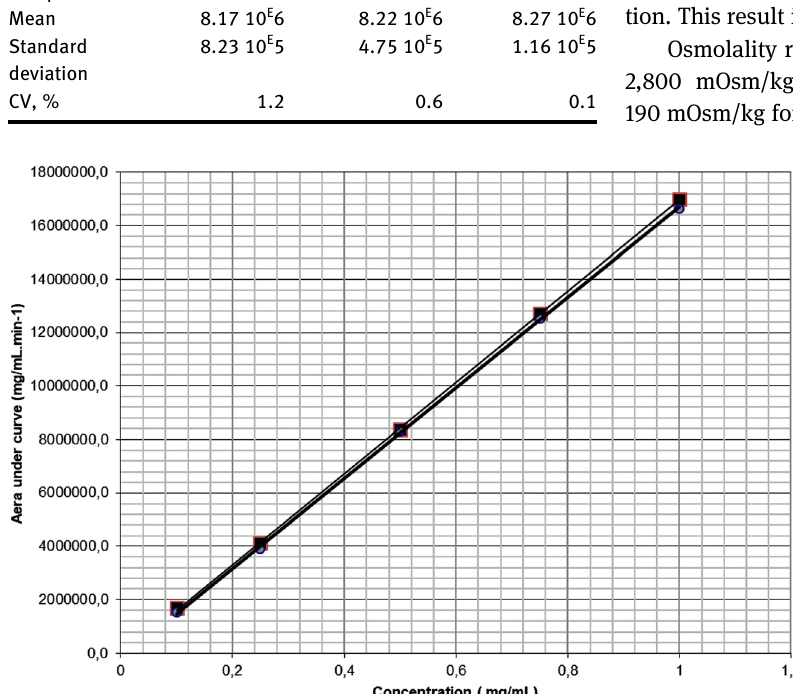
Figure 4: Comparison of HCQ standard curve with and without oral vehicle suspension. (square: HCQ solution, without oral vehicle suspension; round: HCQ suspension, with oral vehicle